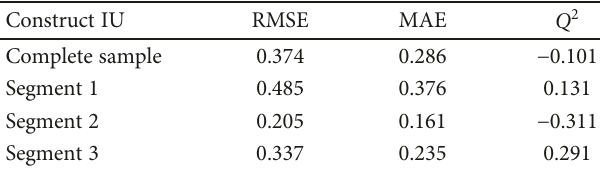
Table 13: Summary of dependent variable